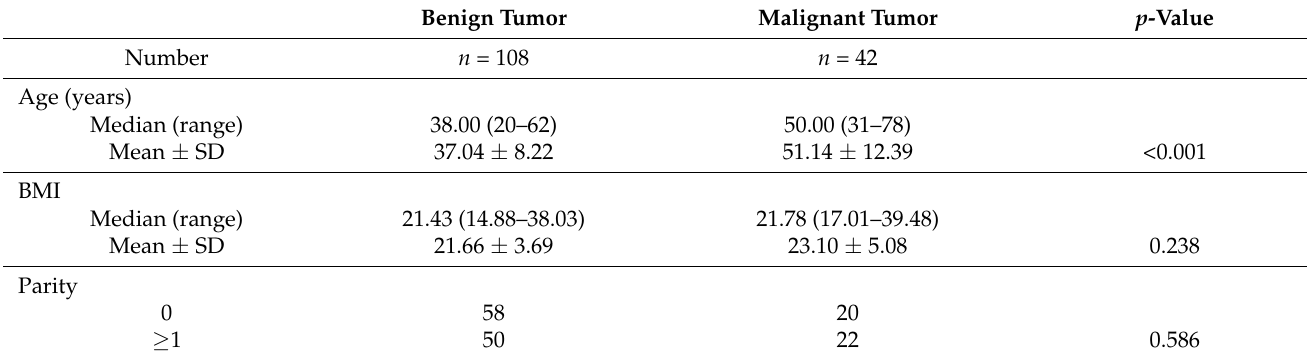
Table 1. Demographic and clinical characteristics of the current